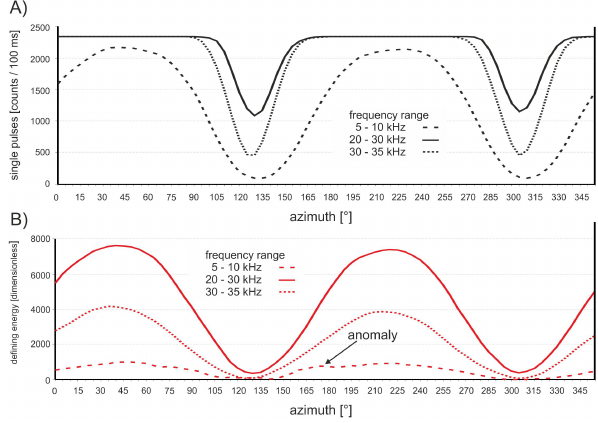
Fig. 9. Comparison of three horizontal measurements using differ- ent frequency ranges but otherwise the same device settings: ampli- fication 107dB and discrimination level of 24. (A) Intensities of sin- gle pulses and (B) defining energy vs. the azimuth (long axis of an- tenna with regard to north = 0 ◦ ). The small anomaly coincides with direction measured during the broadcasting intermission of DHO38 on 15 July 2009 and is probably related to RDL Krasnodar in Rus-